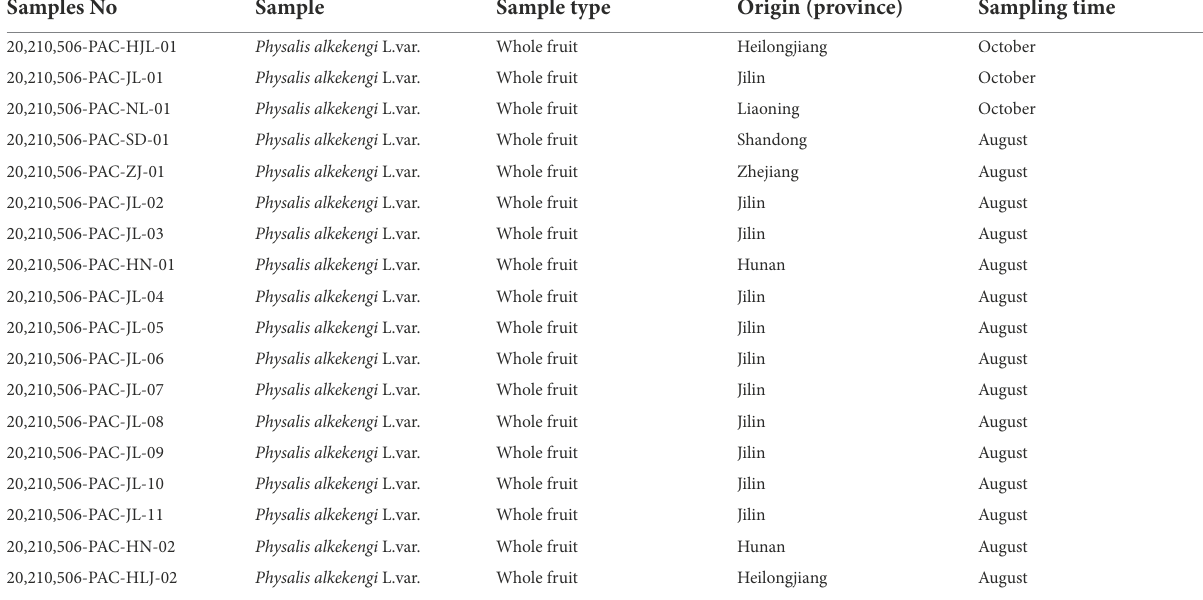
TABLE 1 Geographical distribution of sample